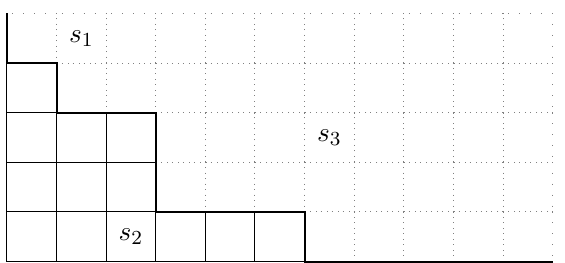
Figure 2 . Arm and leg length with respect to the Young diagram with column lengths f 4 ; 3 ; 3 ; 1 ; 1 ; 1 g . The thick solid line outlines its outer border. A ( s 1 ) = (cid:0) 2, L ( s 1 ) = (cid:0) 2, A ( s 2 ) = 2, L ( s 2 ) = 3, A ( s 3 ) = (cid:0) 3, L ( s 3 ) = (cid:0)